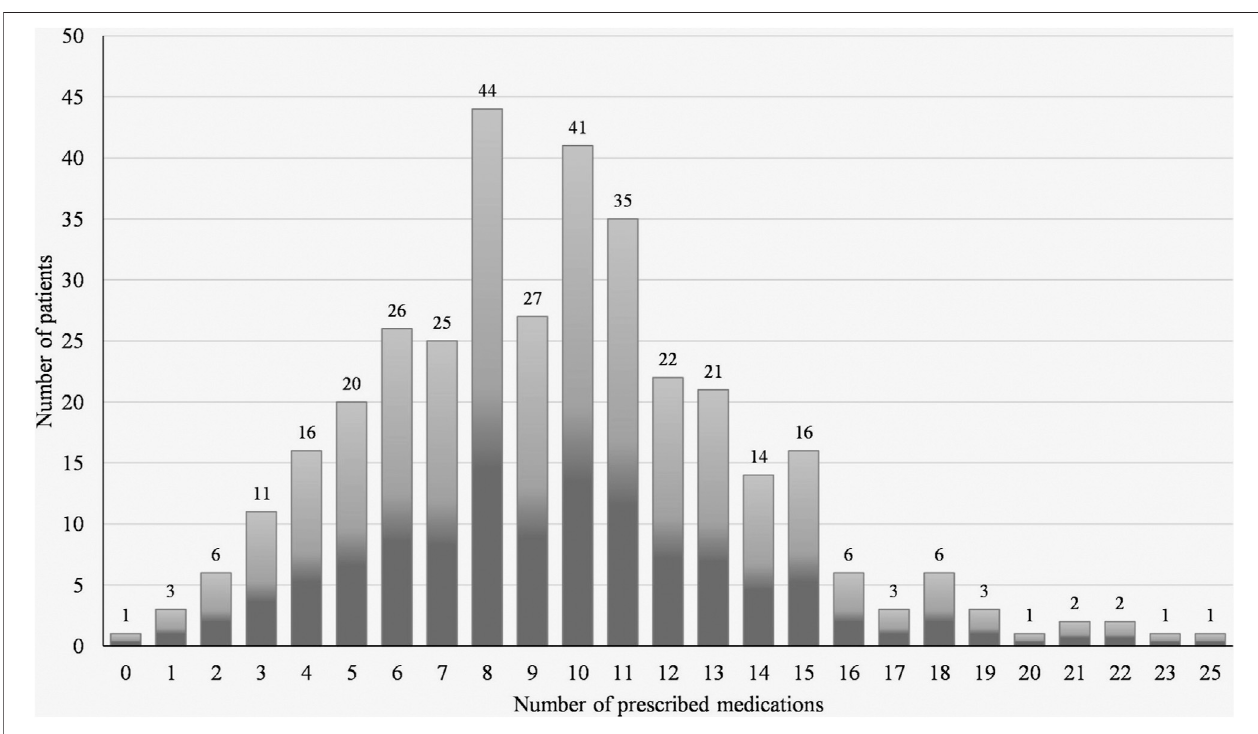
Frontiers in Pharmacology |